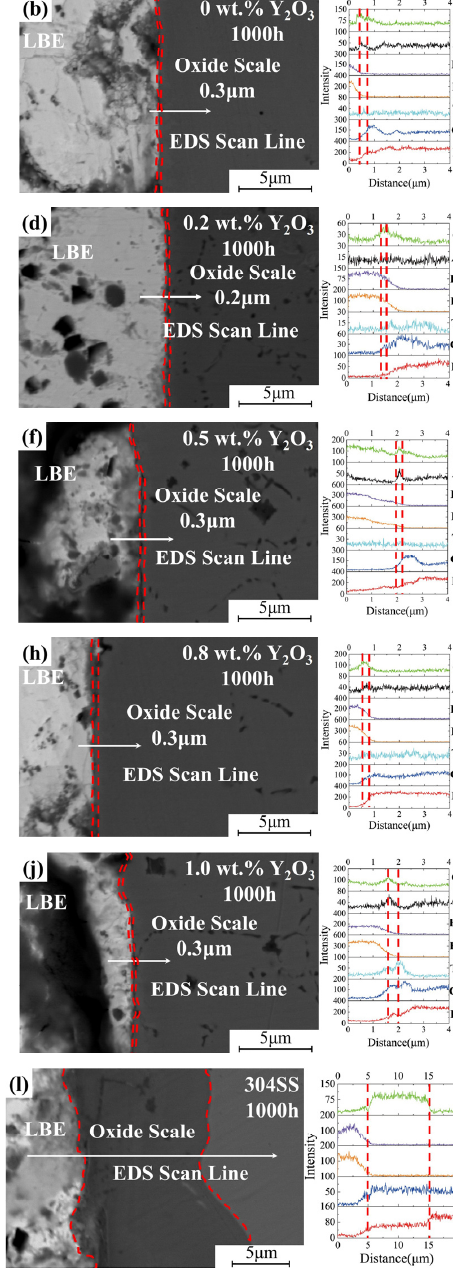
Figure 10. The SEM and EDS analysis results of the specimen cross-sections after LBE corrosion: ( a ) 0 wt.% Y 2 O 3 coating after 500 h corrosion; ( b ) 0 wt.% Y 2 O 3 coating after 1000 h corrosion; ( c ) 0.2